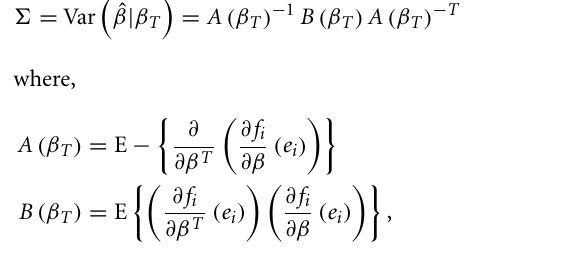
data with equally spaced drug concentrations, while plots (B,D,F) used log-equally spaced data. Plots (A,B) are of the IC 50 method, plots (C,D) are of the Slope method, and (E,F) are of the AUC par